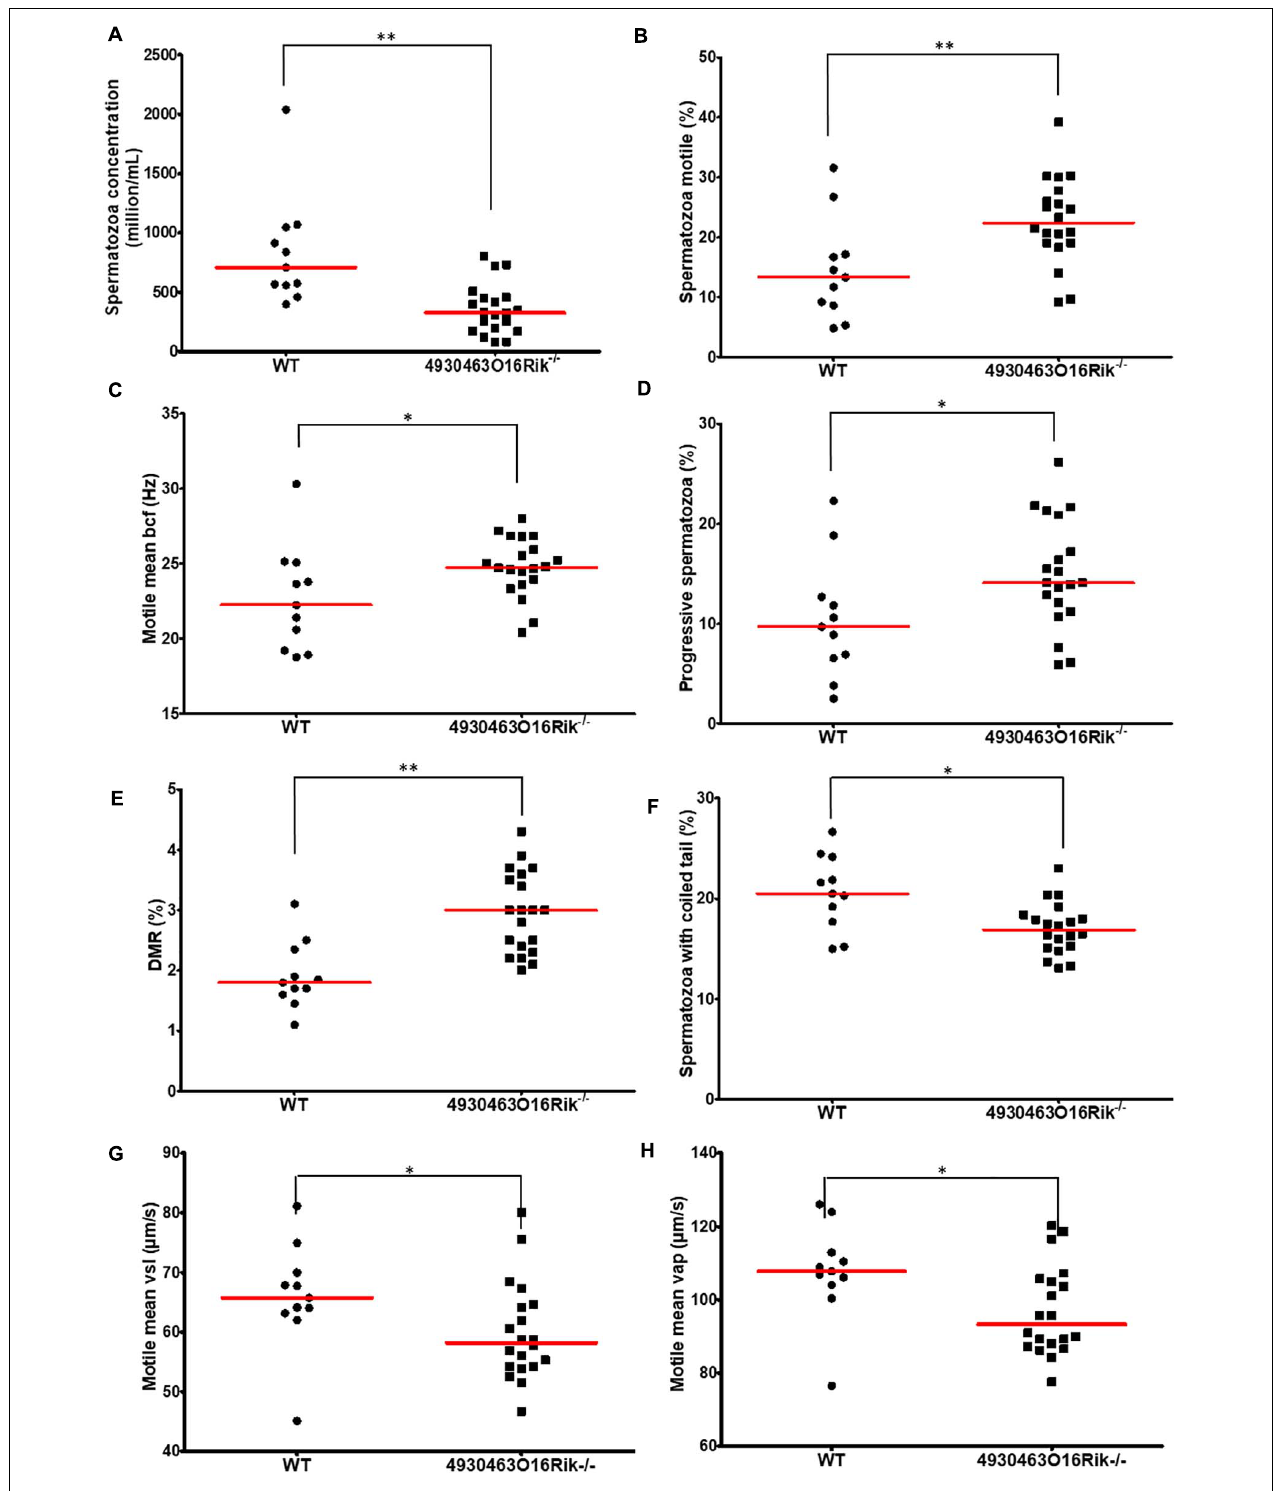
FIGURE 6 | Evaluation of sperm parameters. Comparison of sperm-specific parameters from WT (circle, n = 11) and 4930463O16Rik − / − (square, n = 20) mice. Significantly affected sperm parameters were (A) spermatozoa concentration (10 6 /mL), (B) spermatozoa motility (%), (C) motile mean bcf (beat cross frequency), (D) progressive spermatozoa (%), (E) DMR (distal midpiece reflex, abnormality of the sperm tail (%), (F) spermatozoa with coiled tail (%), (G) motile mean VSL ( µ m/s), and (H) VAP ( µ m/s). Statistical analyses were performed using the non-parametric Kruskal–Wallis test. ∗ p -val < 0.05, ∗∗ p -val < 0.01.